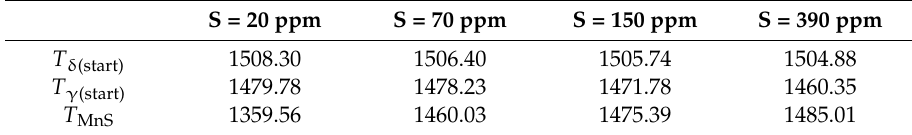
Table 4. Relationship between starting temperature of each phase and sulfur contents.